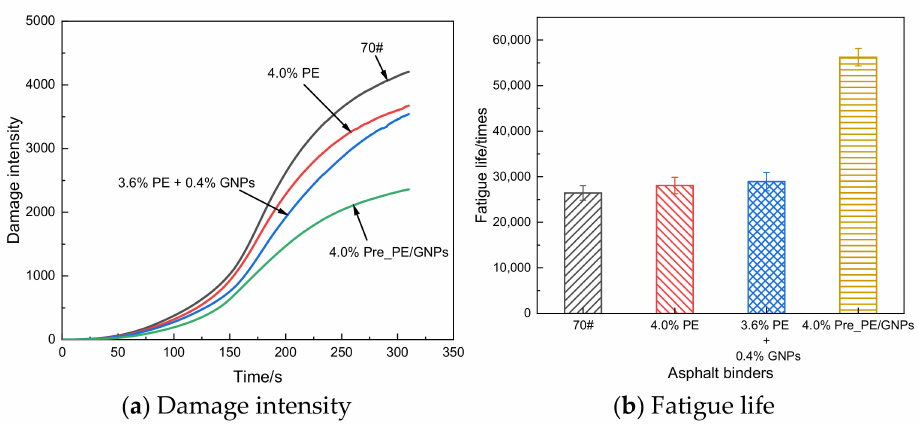
Figure 7. Fatigue test parameters of asphalt binder samples. ( a ) Damage intensity, ( b ) Fatigue